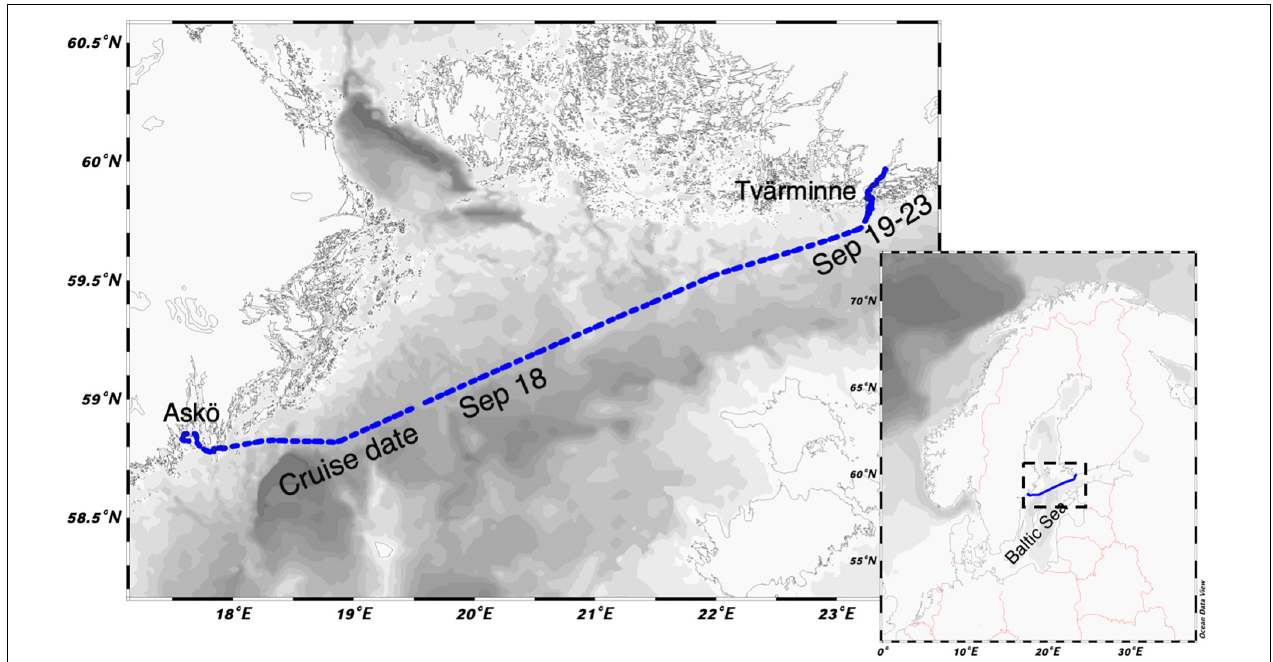
FIGURE 1 | Cruise